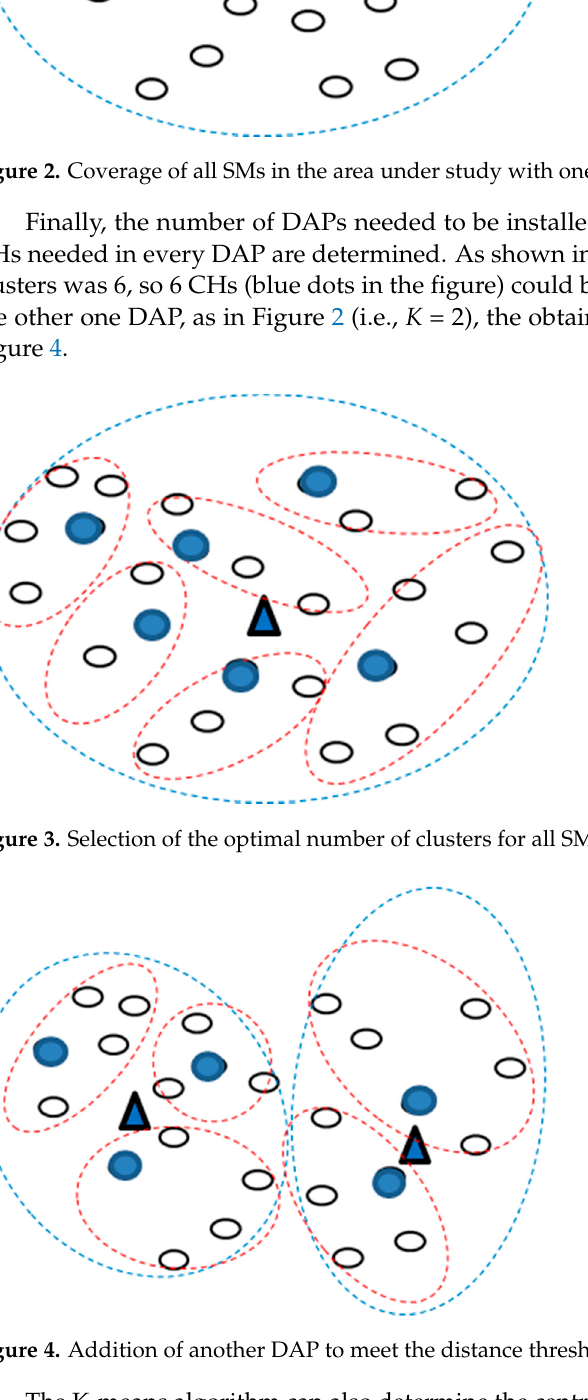
Figure 4. Addition of another DAP to meet the distance threshold, K = 2.